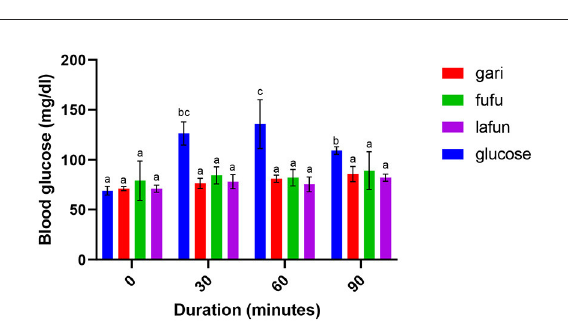
FIGURE4 Blood glucose response after the intake of fufu, lafun and gari from IITA-TMS-IBA182962. Mean values with different letters are significantly different at p < 0.05.